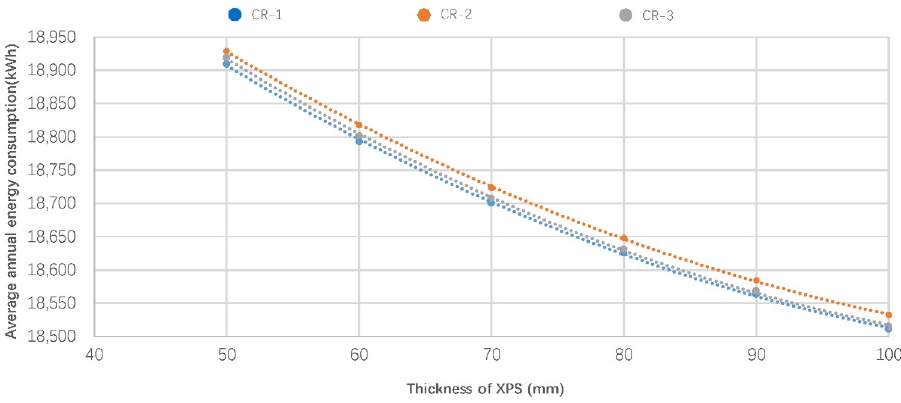
Figure 13. Energy demands of different XPS thicknesses.